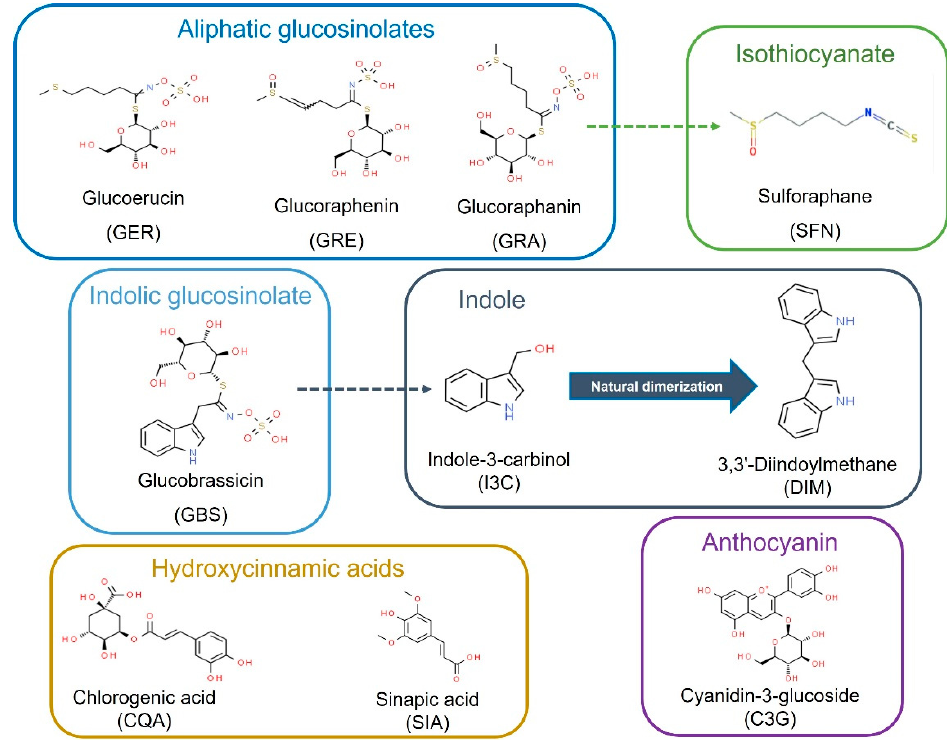
Figure 1. Bioactive compounds selected for this study as commonly present and characteristic of Brassica spp . foods and ingredients. Dash arrows connect precursors and bioactive metabolites.